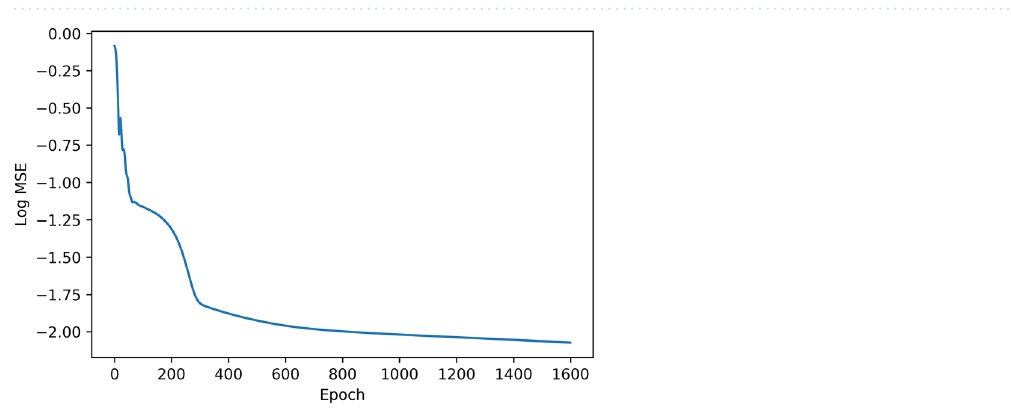
Figure 2. Prediction performance on validation airfoils.